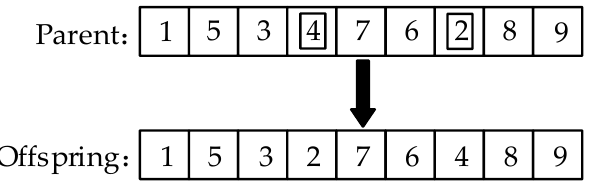
Figure 10. The operation procedure and results of mutation operator.